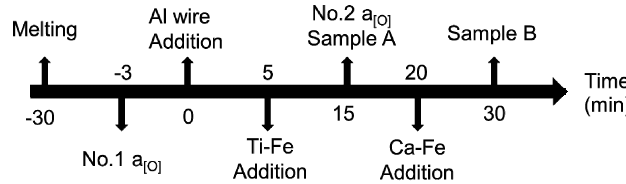
Figure 2. The melting sequence of experiment process and sampling.